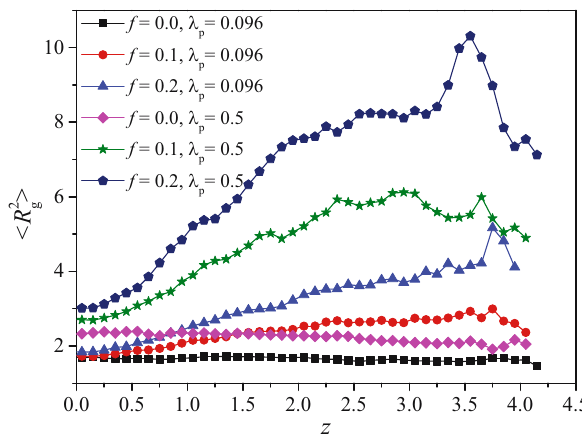
Figure 14: The wormlike chains ’ mean square radius of gyration 〈 〉 R g2 distribution across the slit for the driving force f = 0, 0.1, and 0.2 with = λ 0.096 p eff